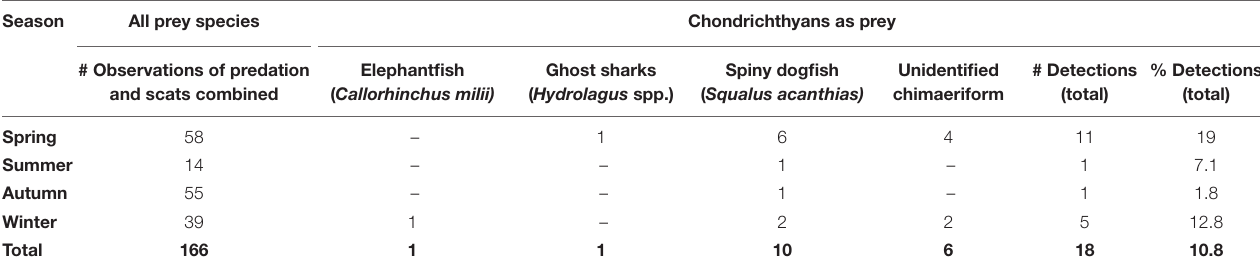
TABLE 1 | Seasonal distribution of chondrichthyan predation records from leopard seals ( Hydrurga leptonyx ) in New Zealand.